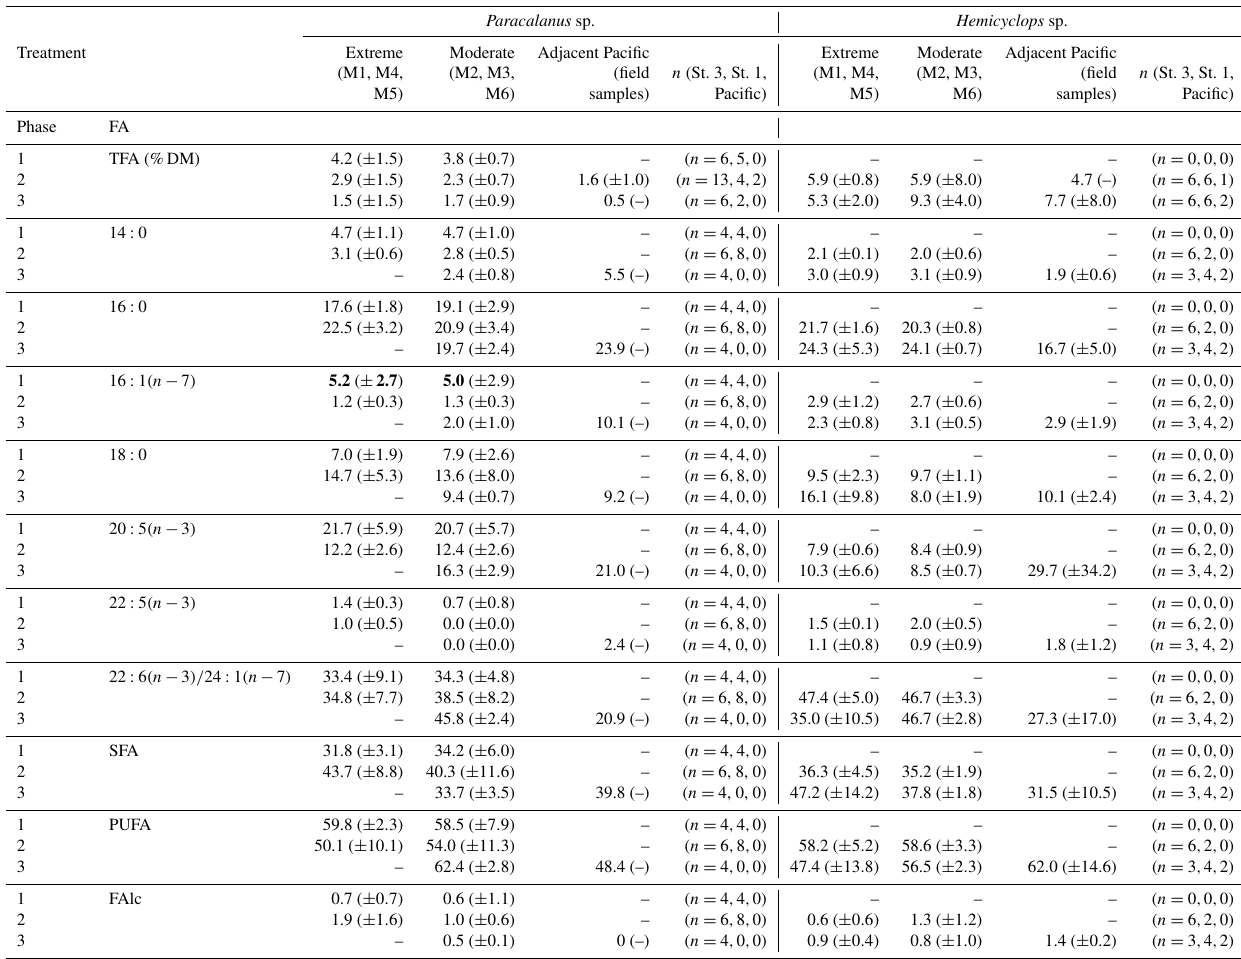
Table 3. Fatty acid compositions (% TFA) of females of Paracalanus sp. and Hemicyclops sp. (mean contributions (%) and 95% confidence intervals – CIs) per treatment and phase of dominant fatty acids as well as the percentage of saturated (SFA), polyunsaturated (PUFA) fatty acids, and free fatty alcohols (FAlc). Data are only presented for samples for which the contribution of FAs in relation to impurities was at least 70%. Of those, only FAs are listed, where the phase mean was ≥ 2% during at least one occasion. Note that for Paracalanus TFAs were related to mesocosm-specific average dry mass (DM) of weighed females collected for gut fluorescence; in the case of Hemicyclops DM could be determined after lyophilization of copepod samples for lipid analysis and was subsequently used for calculation of percent TFA. Phase 1: day 1 to OMZ water addition (day 11–12), phase 2: starting with the OMZ water addition until day 40, phase 3: day 40 until experiment